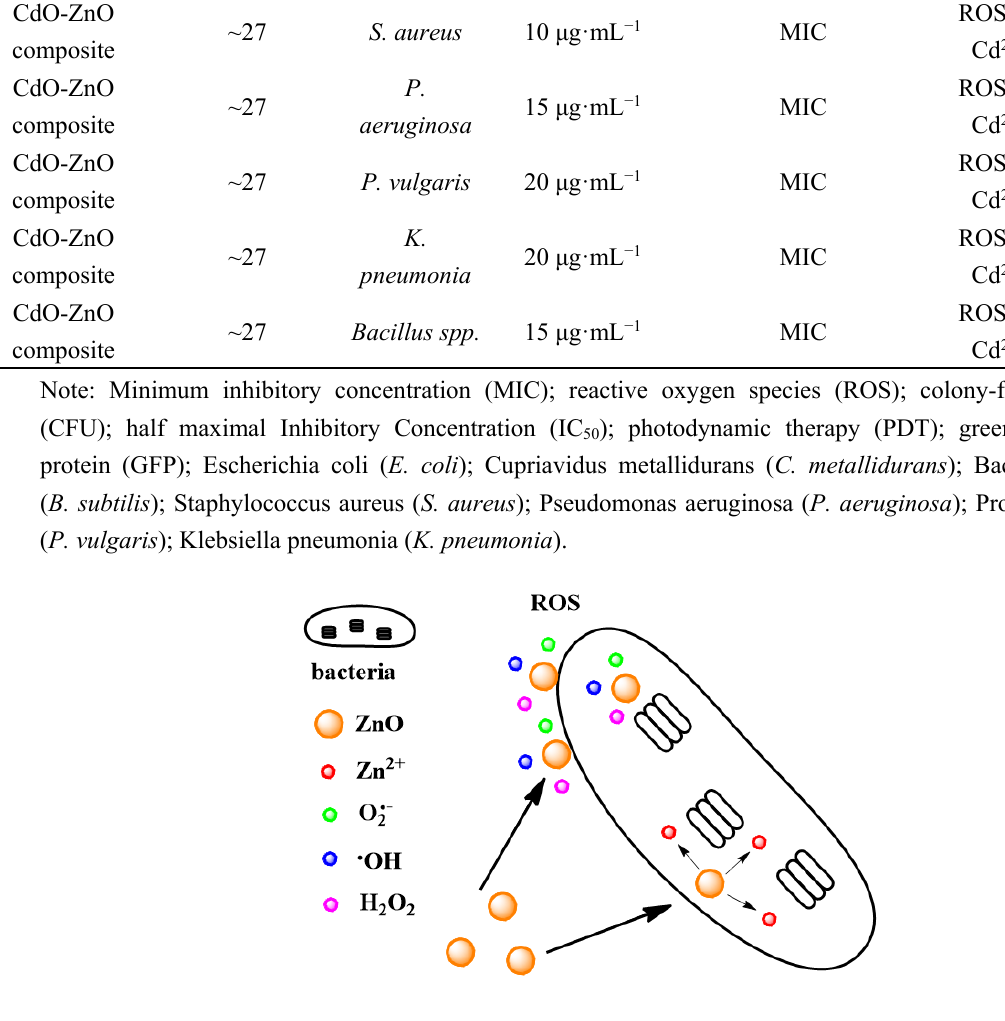
Figure 6. Schematic illustration of antibacterial activity of ZnO